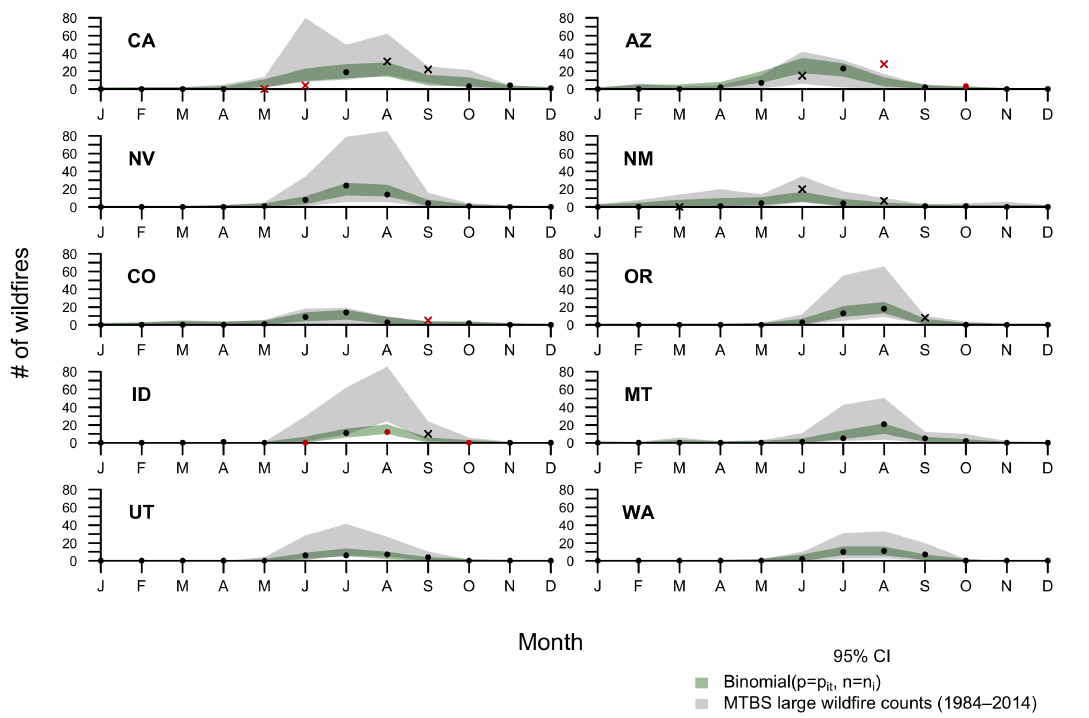
Figure 4. The number of large (>405 ha) wildfires for each state and month as reported from WoMBATS data between 2018 and 2020 compared to historical expectations as derived from MTBS fire occurrence data. Each point represents the number of large wildfires in the WoMBATS data for each state and month. The envelope represents the central 95th percentile of the expected wildfire counts from the binomial distribution (expected monthly wildfire counts conditional on total state counts) and empirical distribution (expected wildfire counts for that state, month, and observation- window based on observations). Points that fall outside the binomial distribution’s central 95th percentile of identified with an “X”. Points that fall outside the empirical distribution’s central 95th percentile are colored